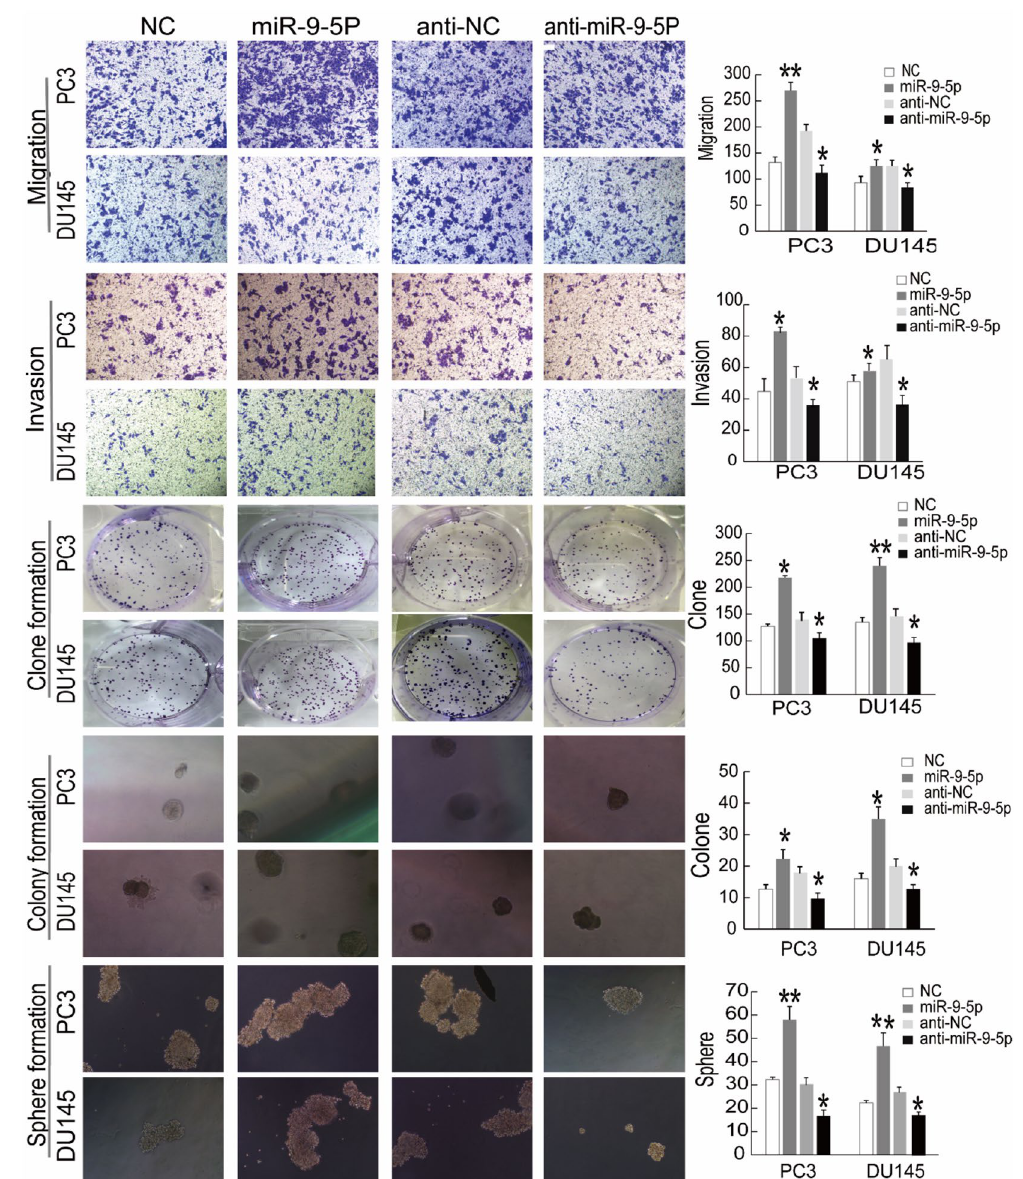
Figure 3. MiR-9-5p was significantly associated with PCa cell invasion, migration, and clonal, clonogenic and sphere-forming activities in vitro. From the upper part to the lower part; Transwell migration assays, invasion assays, clonal experiments, 3-D Matrigel clonogenic assays and sphere formation assays were separately performed to determine the metastasis and stemness characteristics of PCa cells. PC3 and DU145 cells were transfected with miR-9-5p mimic, mimic NC, miR-9-5p inhibitor or inhibitor NC for 48 h. All results are shown as the mean ± S.D. from three independent experiments. Statistical analysis was carried out using GraphPad Prism 7.0 Software (GraphPad Software, La Jolla, CA). * P < 0.05, ** P <